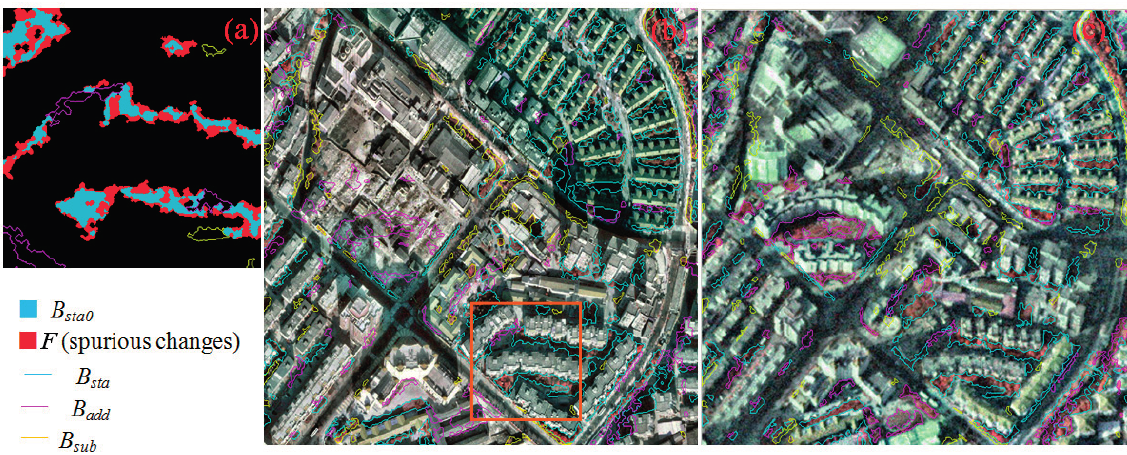
Figure 7. An example of vegetation change detection with spatial analyses. ( a ) The initial stable and detected spurious-change objects in a case site (in the orange rectangle in Figure 7 b ; ( b ) and ( c ) the readjusted objects with the back images of date 1 and date 2,